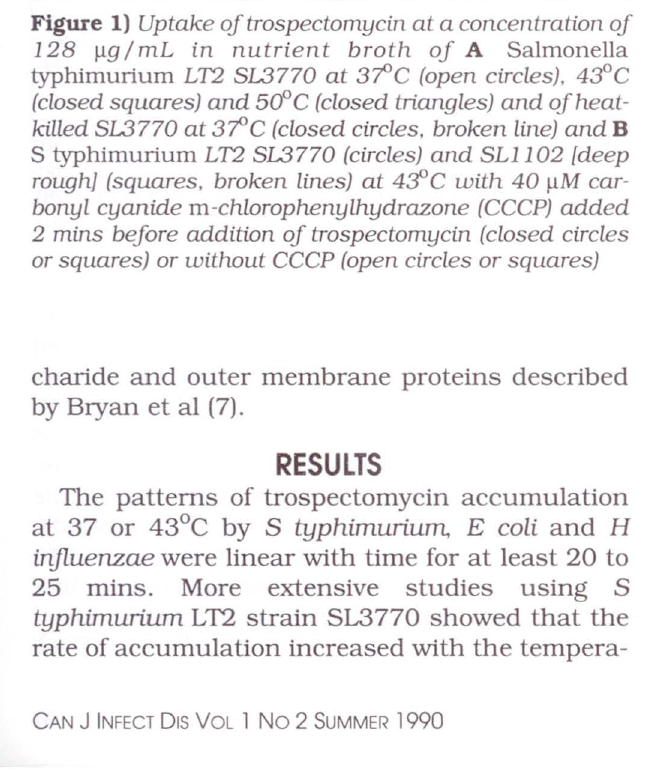
Figure 2) Lineweaver-Burk plot of 1/V (ng trospec tomycin/min/mg dry weight of cells) based on the initial 1 0 mins of uptake in nutrient broth at 4SO C with 1 0 mM magnesium chloride (closed circles or squares) or without any addition (open circles or squares) versus 1 IS (con centration of trospectomycin in mg/mL) for Salmonella typhimurium LT2 SL3770 (circles) [parent] and LT2 SLll 02 (squares) [deep rough mutant]. Lines were drawn using the least squares method. As this is a reciprocal plot, faster uptake is shown as the line with the lower slope